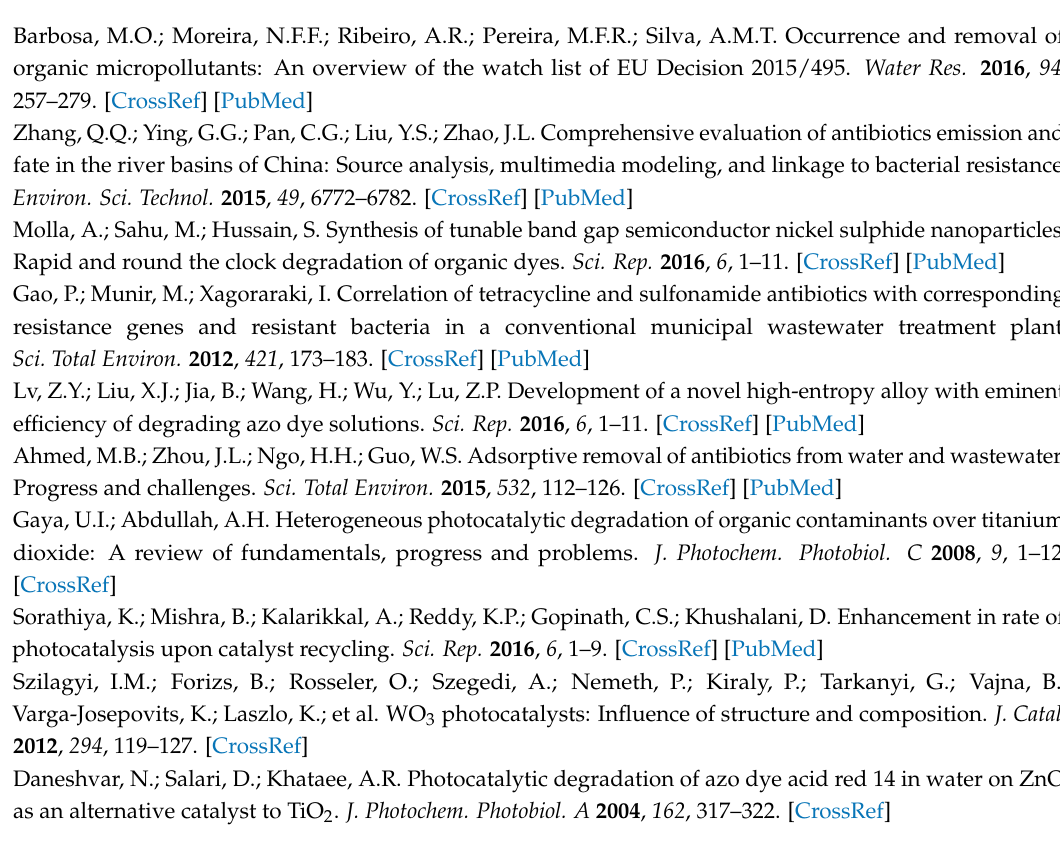
Figure S1: A schematic diagram of photocatalytic equipment, Figure S2: Emission spectrum of Xe lamp with 420 nm filter, Figure S3: Influence of adsorption process on: (a) RhB solution (15 mg/L, 70 mL); and (b) TC-HCl solution (40 mg/L, 100 mL) containing 30 mg 4% g-C 3 N 4 -mNb 2 O 5 powder under dark, Figure S4: Absorption changes of: (a) RhB solution (15 mg/L, 70 mL); and (b) TC-HCl solution (40 mg/L, 100 mL) containing 30 mg 4% g-C 3 N 4 -mNb 2 O 5 powder under visible light irradiation, Figure S5: Standard curves of absorbance intensity vs. concentration of: (a) RhB solution; and (b) TC-HCl solution, Table S1: The elements content of 4% g-C 3 N 4 -mNb 2 O 5 by EDS